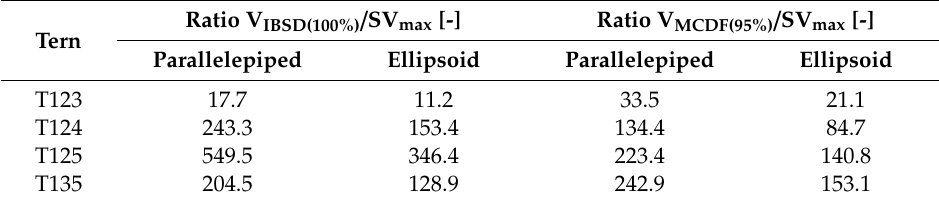
Table 8. Ratios calculated for the considered terms.